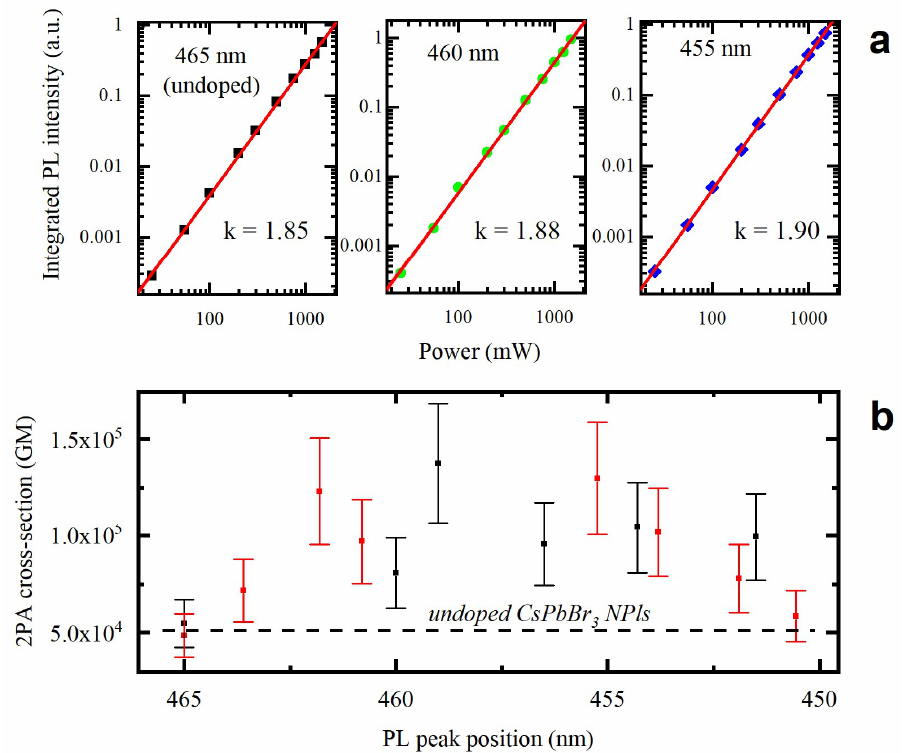
Figure 5. ( a ) The log–log plots of the integrated PL intensity vs. excitation power obtained for the parent and Cd 2+ -doped samples. ( b ) The dependence of the 2PA absorption cross section on emission peak position for two batches of Cd 2+ -doped samples. The dashed line indicates the value obtained for the undoped sample.